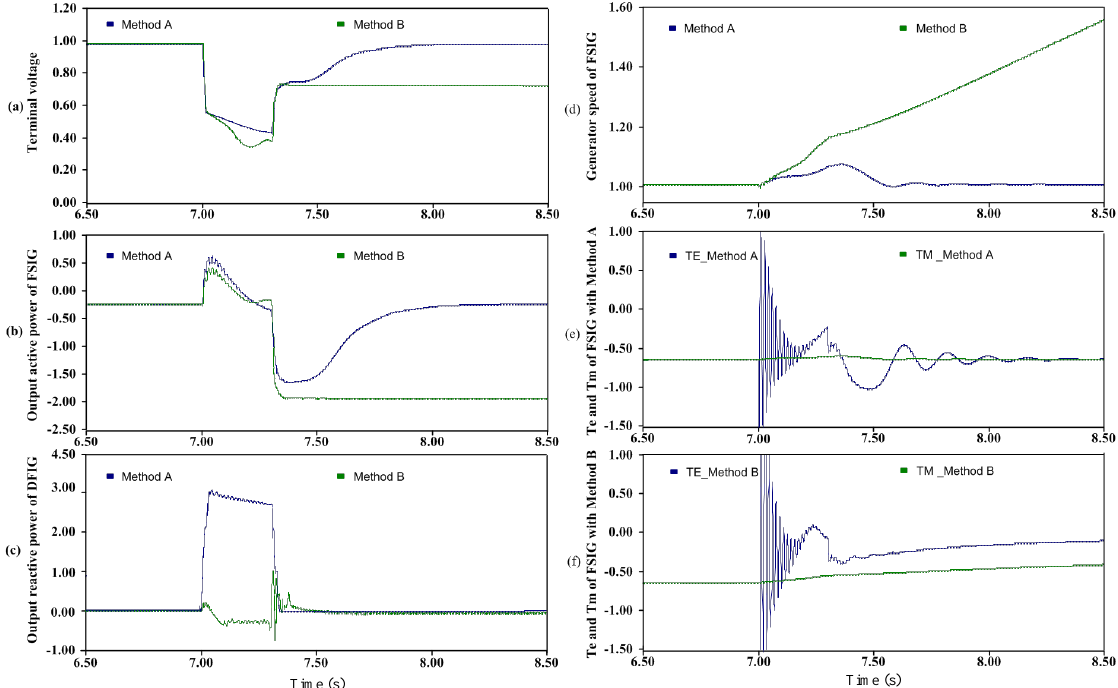
Figure 13. Impacts of the reactive power support capability of DFIG-ESS to nearby FSIG-based wind farms during serious unbalanced voltage drops: ( a ) terminal voltage; ( b ) output reactive power of FSIG; ( c ) output reactive power of DFIG-ESS; ( d ) generator speed of FSIG; ( e ) electromagnetic torque and mechanical torque of FSIG with Method A; and ( f ) electromagnetic torque and mechanical torque of FSIG with Method